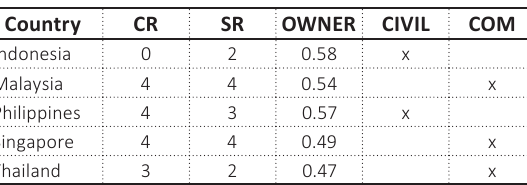
Table 5. Specific characteristics of the legal